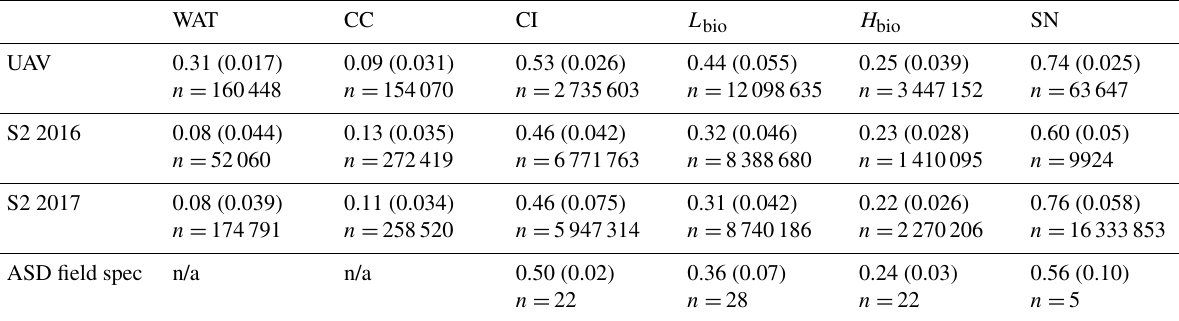
Table 3. Summary of the albedo for each surface class as predicted from our classified UAV image, the Sentinel-2 image for 2016 (S2 2016) and 2017 (S2 2017), and as measured using field spectroscopy (ASD Field Spec) at our field site in 2017 (we do not have cosine collector albedo measurements for water or cryoconite surfaces). The reported values are the mean, the standard deviation in brackets and the number of observations.